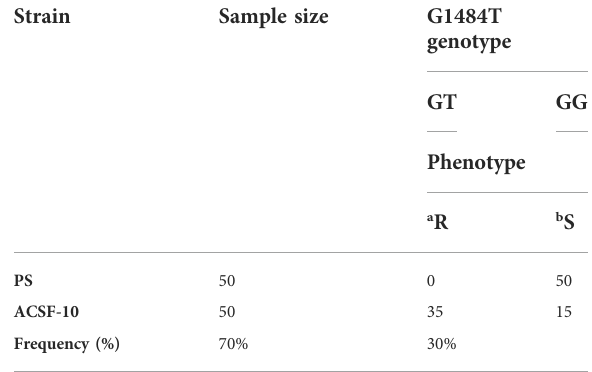
TABLE 5 Analysis of genotype and phenotype correlation of G1484 T mutation in protein sequence of Aedes aegypti based on the mutation frequency in the DNA sequence alignment.